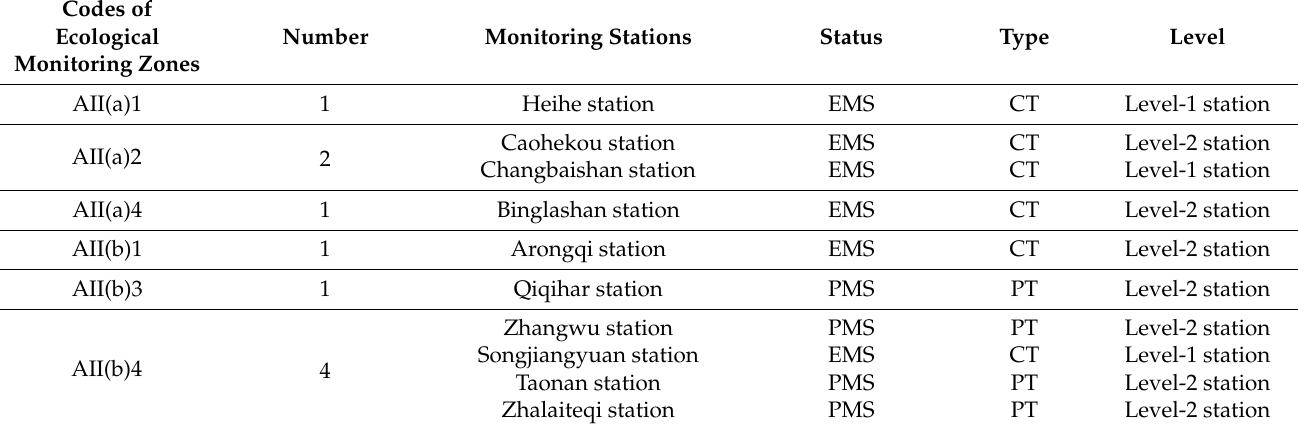
Table 4. The layout of monitoring stations for